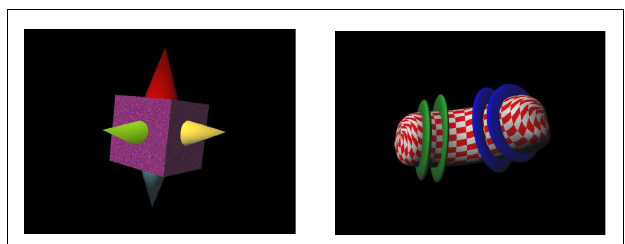
FIGURE 2 | Novel objects that received